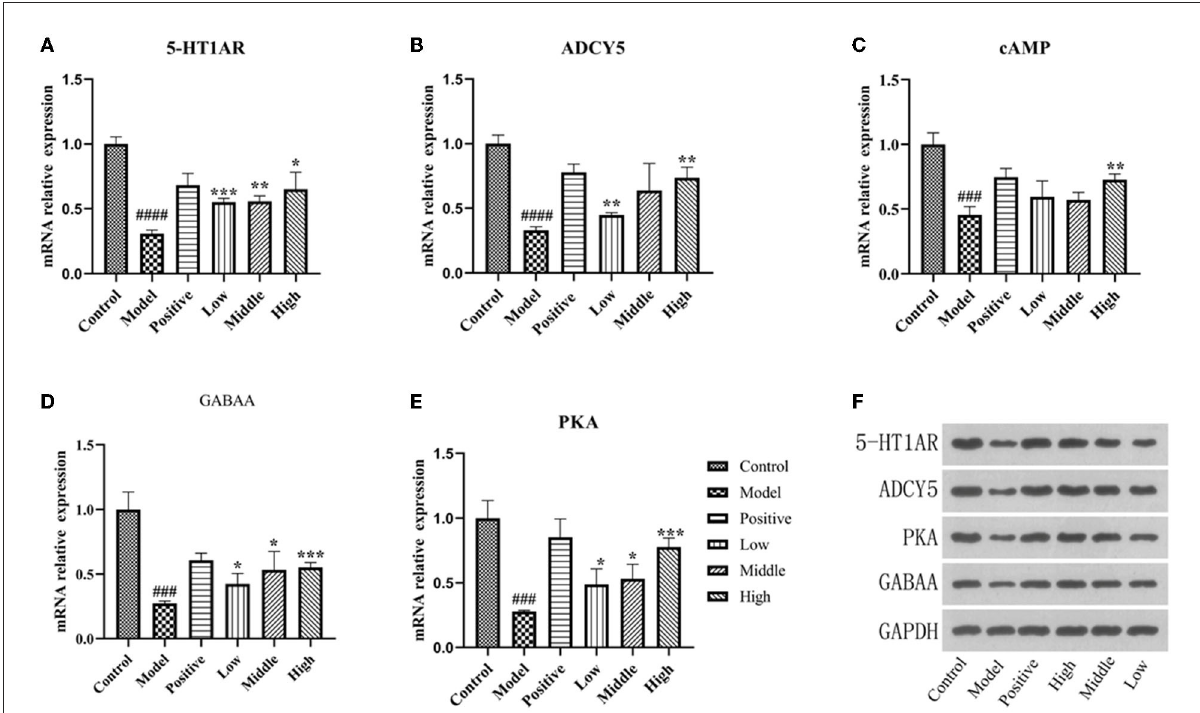
FIGURE7 PCR and Western blot results. (A–E) The mRNA expression of 5-HT1AR, ADCY5, PKA, and GABAA detected by PCR. (F) The protein expression of 5-HT1AR, ADCY5, PKA, and GABAA detected by WB in hippocampus (compared with the normal group ### p ' < 0.001,' #### p ' < 0.0001,'compared with the model group, * p < 0.05, ** p < 0.01,' *** p <